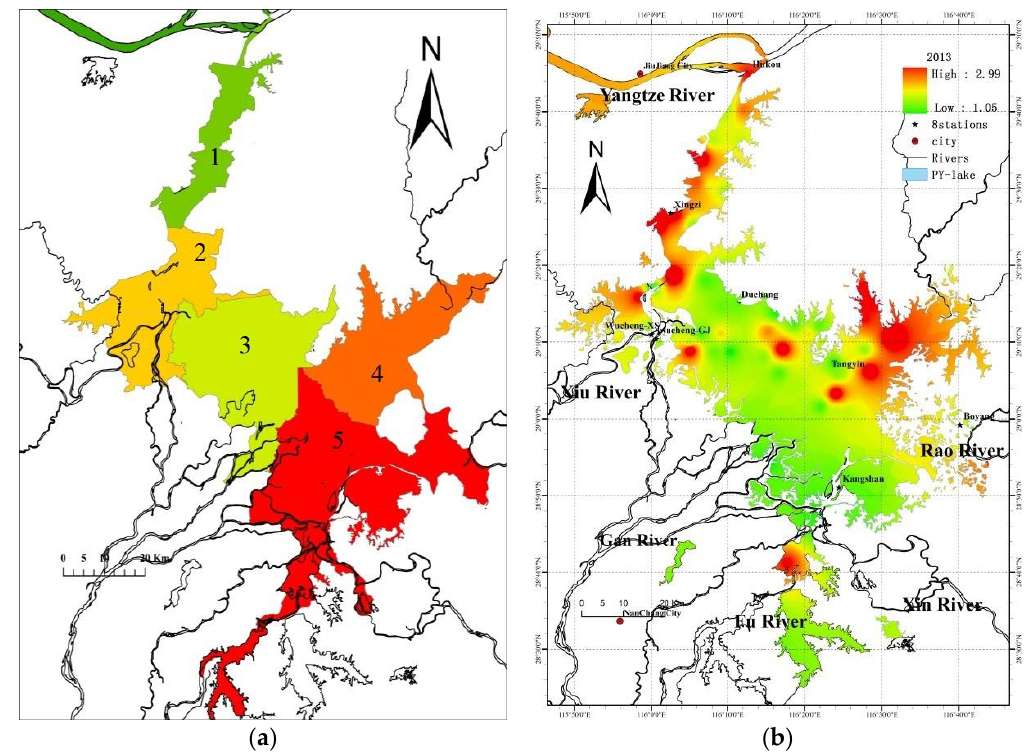
Figure 9. Partition map of Poyang Lake ( a ) and assessment results of the aquatic ecosystem in Poyang Lake in July 2013 ( b ). 1. Northern region connected to Yangtze River, 2. Northwestern region, 3. Central lake, 4. Eastern region, 5. Southern region.